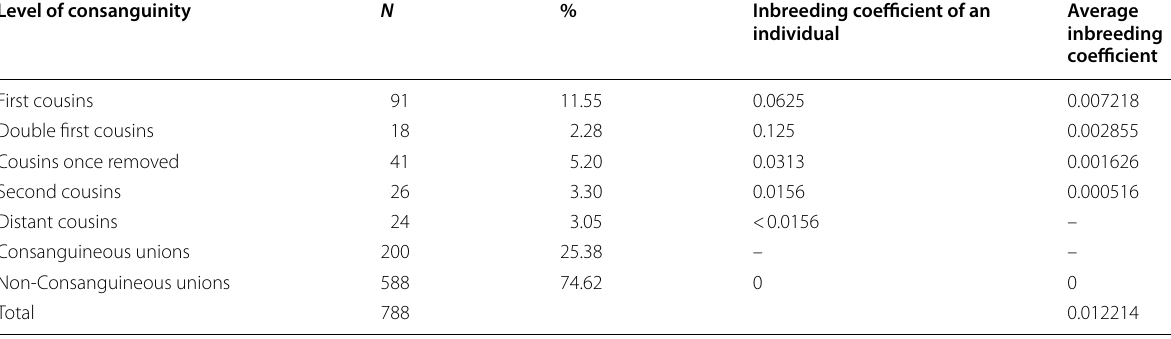
Table 2 Distribution of marriages according to the level of consanguinity in the Chaouia population Level of consanguinity N Inbreeding coefficient of an